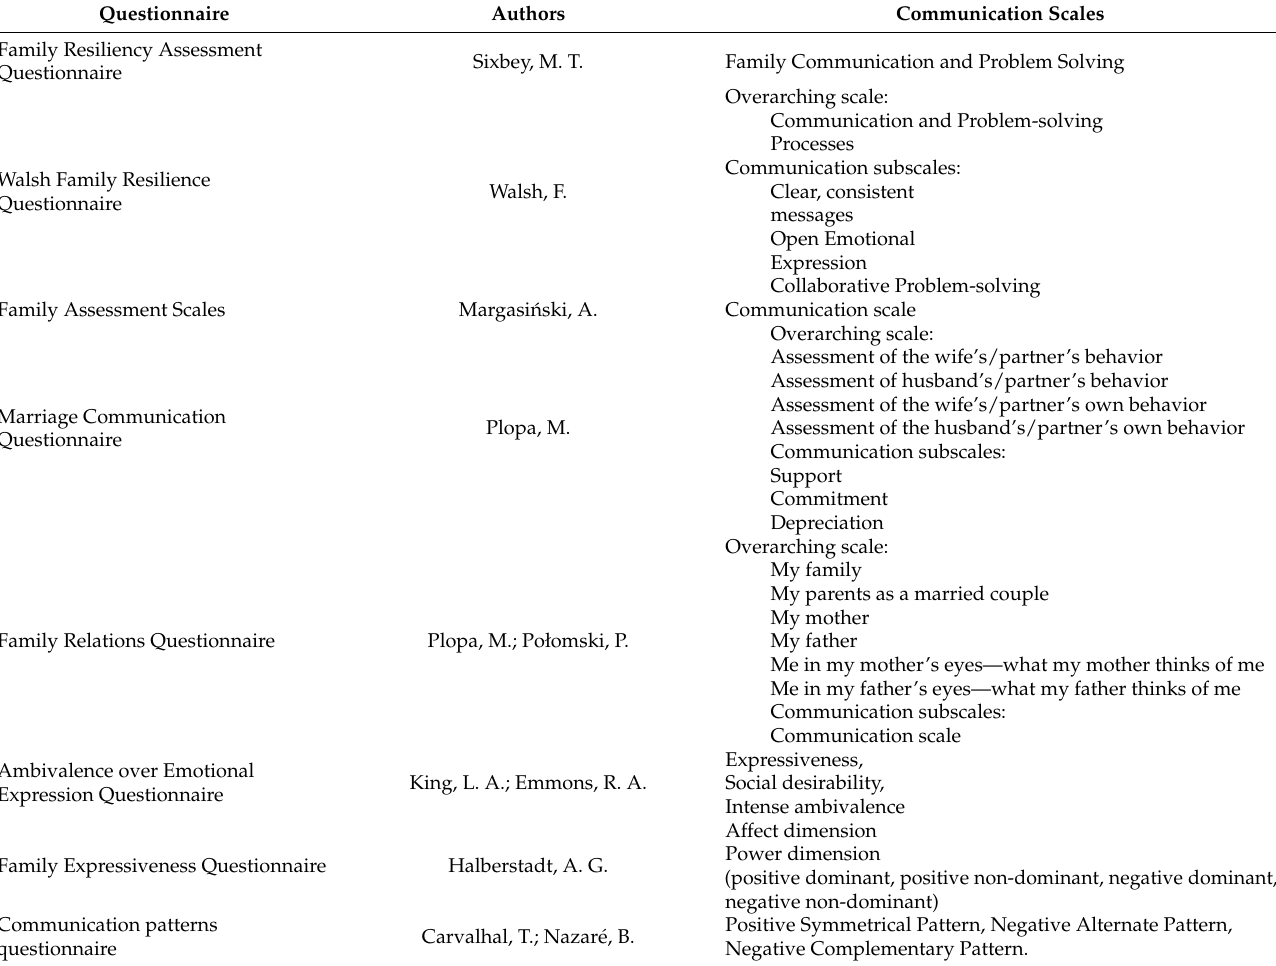
Table 1. Subscales of questionnaires measuring family